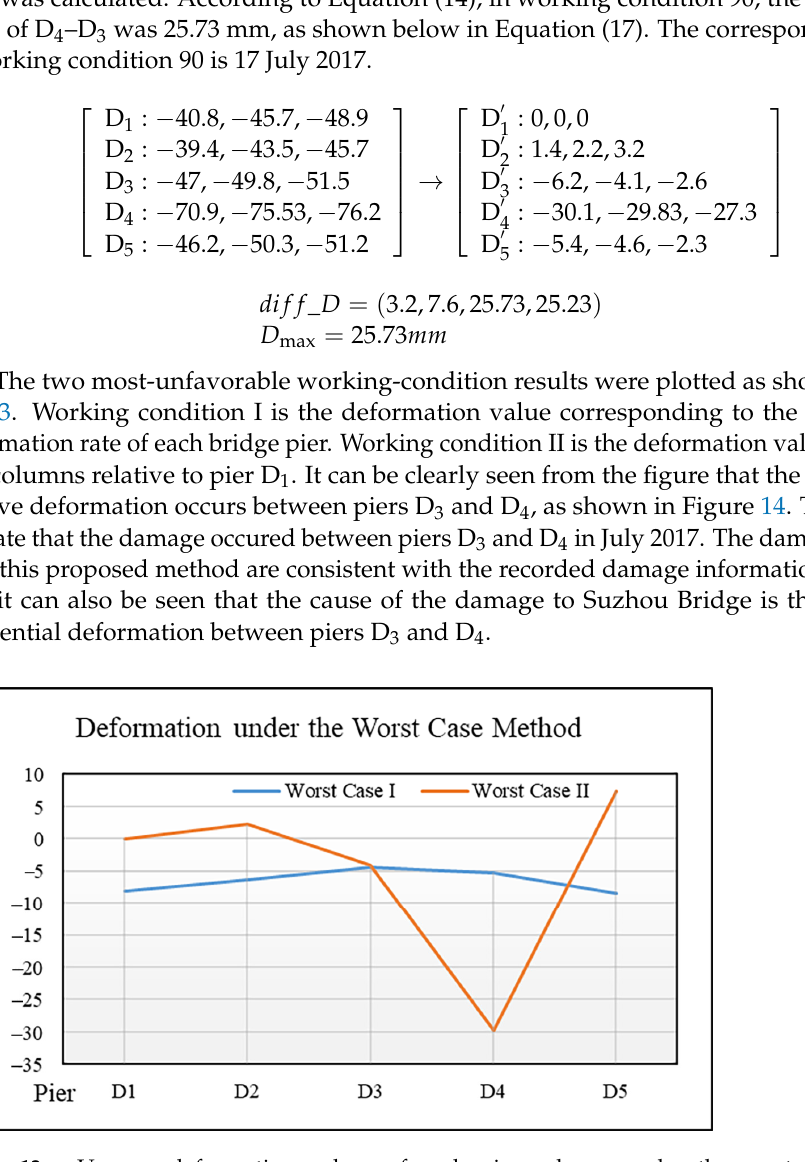
Figure 13. Uneven deformation values of each pier column under the most-unfavorable working conditions.